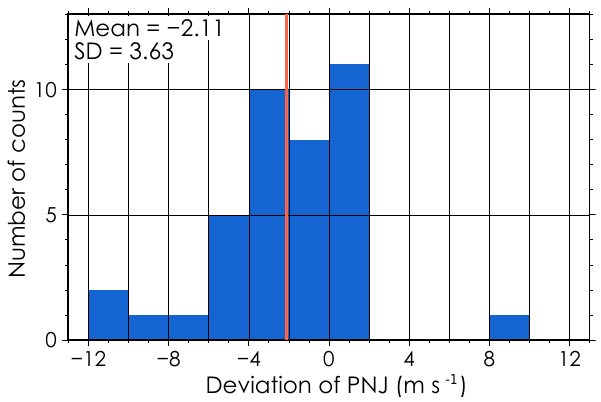
Figure C1. Histogram of the deviation of the PNJ in late Novem- ber from the expected by sinusoidal seasonal evolution in each year (2.0ms − 1 bins). The horizontal axis shows the deviation for the center of each bin. The vertical axis indicates the number of counts for each bin. The labels on the upper-left corner show the mean and standard deviation. The orange lines indicate the mean. The nega- tive sign indicates the occurrence of the short